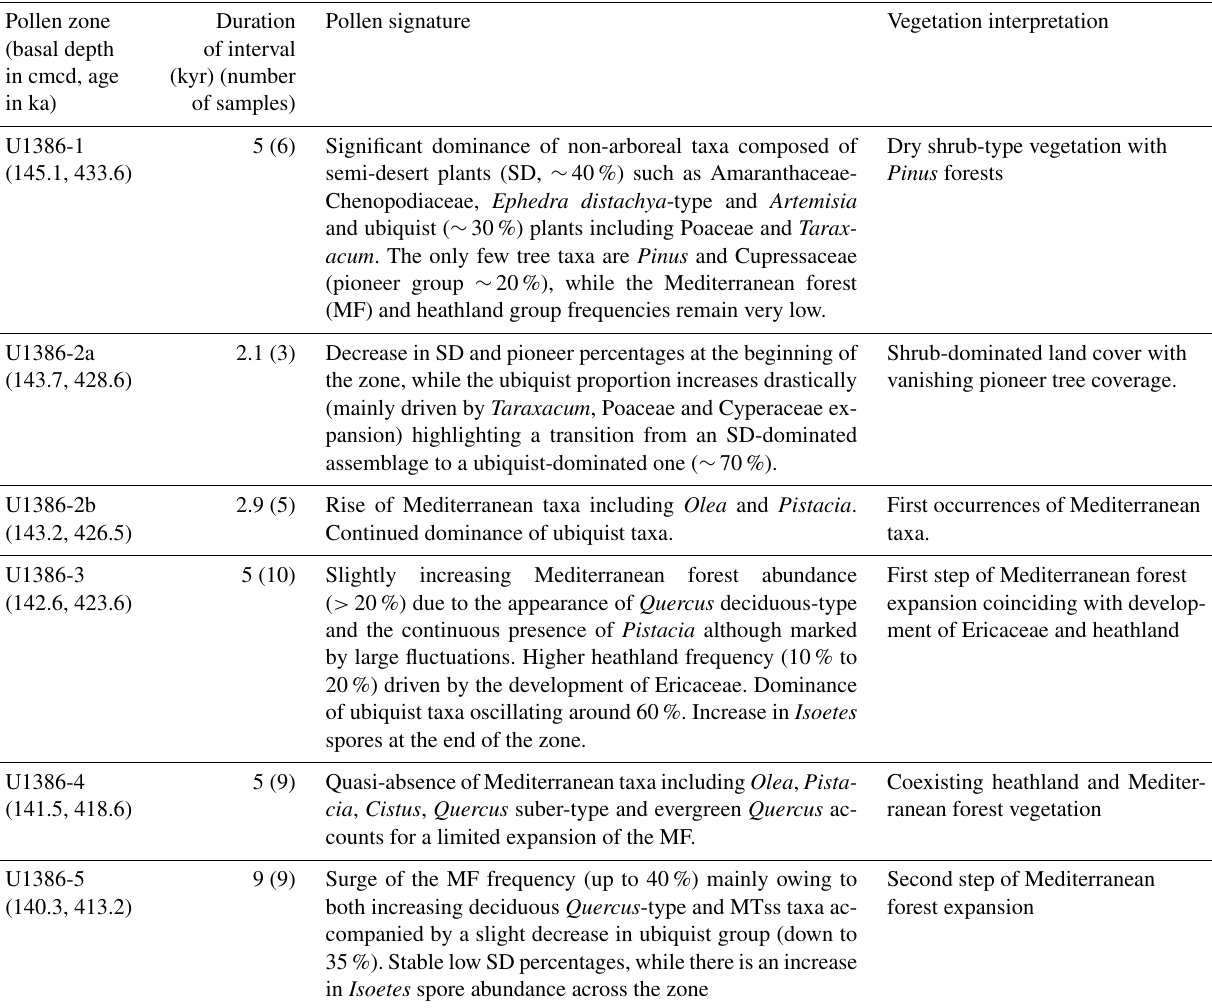
Table 3. Description and interpretation of the TV pollen record at site U1386 by pollen zones. Pollen